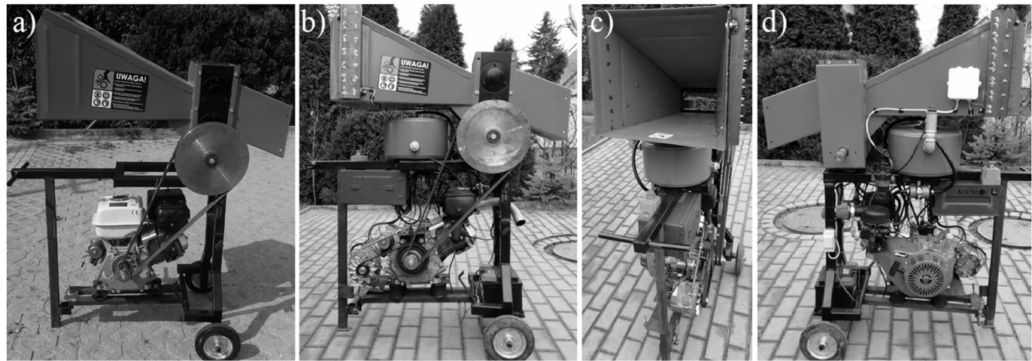
Figure 1. Red Dragon RS − 100 type cylindrical chipper: ( a ) with a German GX 390 type engine; ( b – d ) with the adaptive control system.